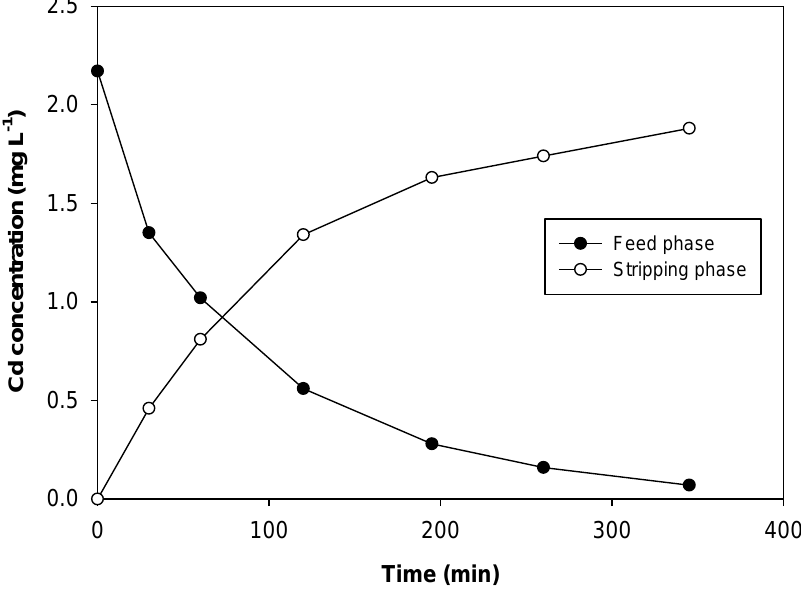
Figure 5. Transient concentration curves in Cd transport experiments in spiked seawater sample.